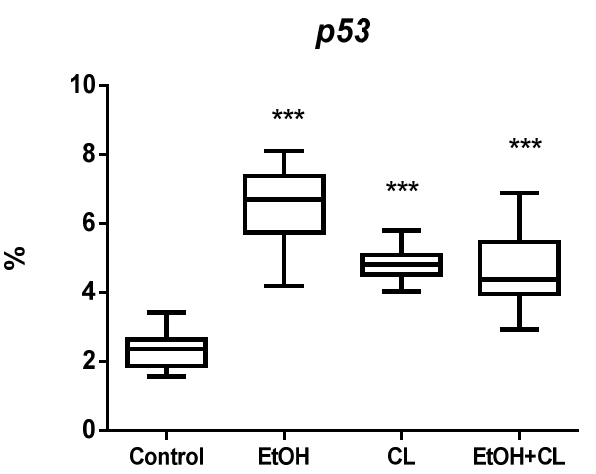
Figure 5. Levels of p53 expression in hepatocytes of rats. *** ( p ≤ 0.0005)—in comparison with the parameters of animals of the control group.